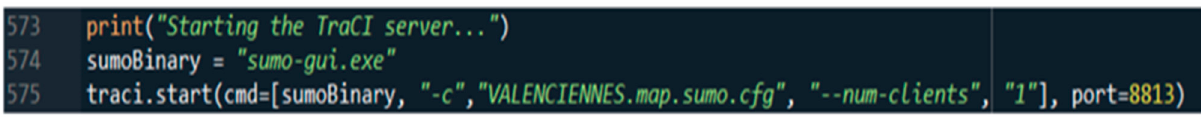
Figure 8. Interfacing TraCi with SUMO.